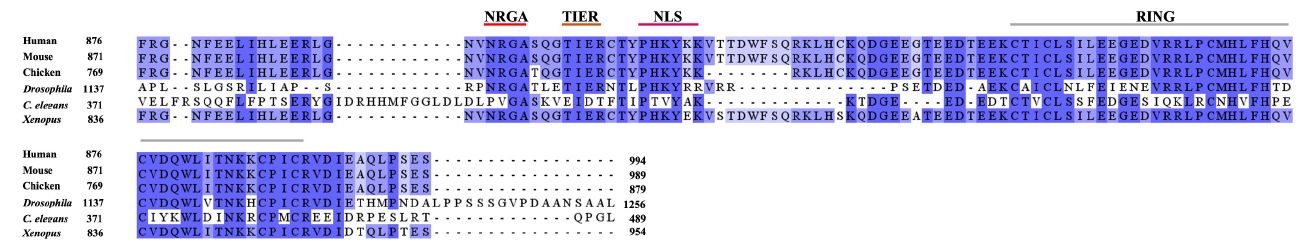
Figure 1. Alignment of C ‐ terminus sequence of Arkadia from different organisms produced by Jalview and colored according to their similarities in amino acids sequence (>80% dark blue, > 60% medium dark blue, > 40% light blue, ≤ 40% no color). The NRGA, TIER, NLS, and RING domain are highlighted in orange, brown, purple, and grey lines, respectively.